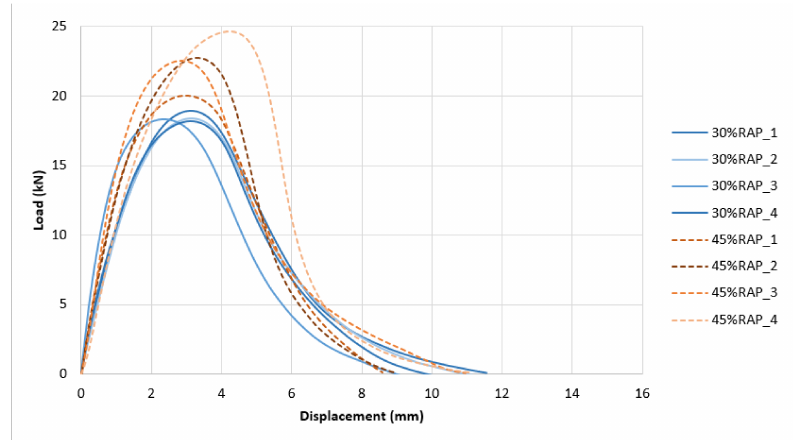
Figure 6. Load vs. Displacement Curves: 30-Superpave, 45-Superpave.